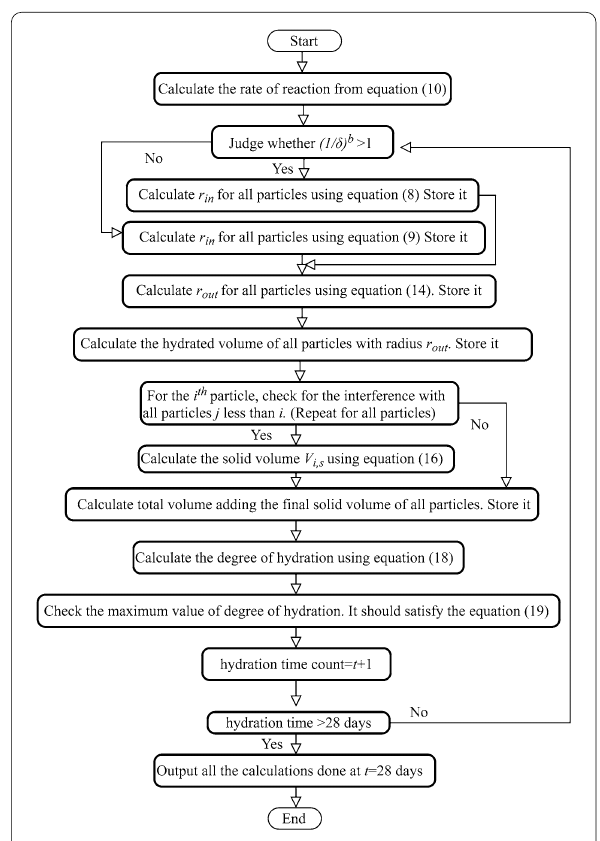
Fig. 3 Flowchart for cement hydration